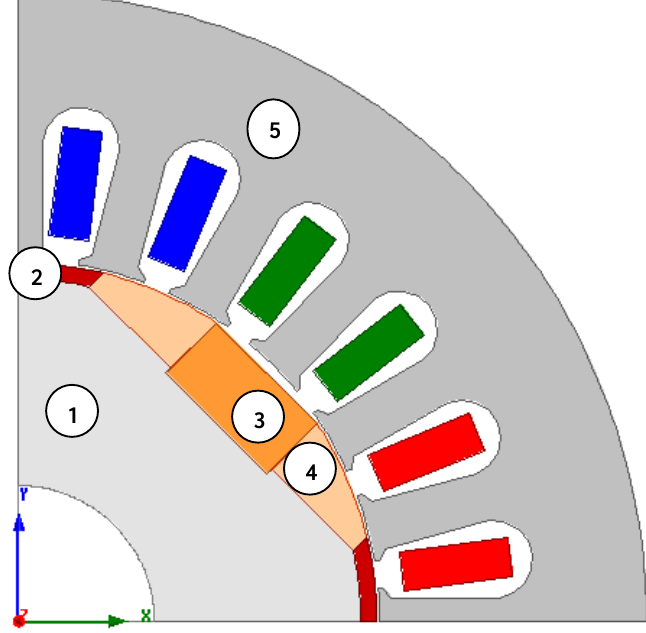
Figure 1. 2D FEM model of permanent magnet synchronous motor with copper cage and hybrid magnets 1: soft magnetic composite core, 2: copper cage, 3: Sm-Co magnet, 4:Nd-Fe-B bonded magnet, 5: electrical sheets of the